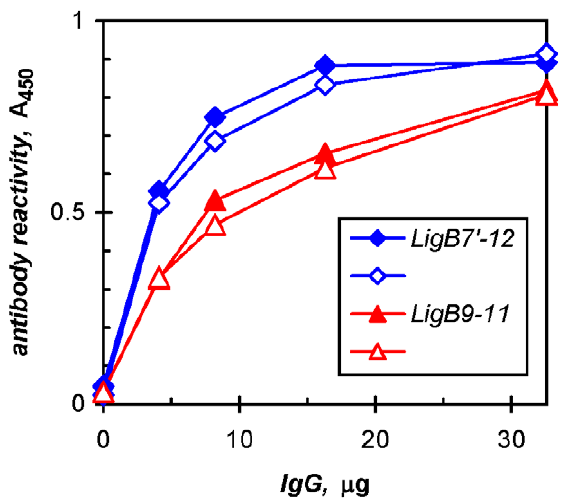
Figure 6. Leptospirosis patient antibodies recognize fibronec- tin/fibrinogen-binding region of LigB. Immunoglobulins purified from a pool of antisera of patients with acute infection (closed symbol) and from a convalescent patient (open symbol) were titrated against LigB proteins in an ELISA.